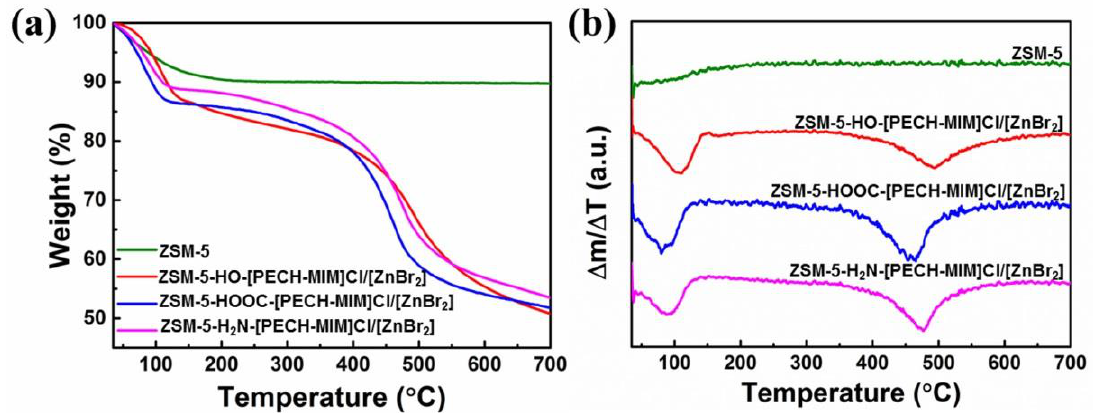
Figure 5. ( a ) TG and ( b ) DTG of zeolite ZSM-5 and its immobilized catalysts: ZSM-5-HO-[PECH-MIM]Cl/[ZnBr 2 ]; ZSM-5-HOOC-[PECH-MIM]Cl/[ZnBr 2 ]; and ZSM-5-H 2 N-[PECH-MIM]Cl/[ZnBr 2